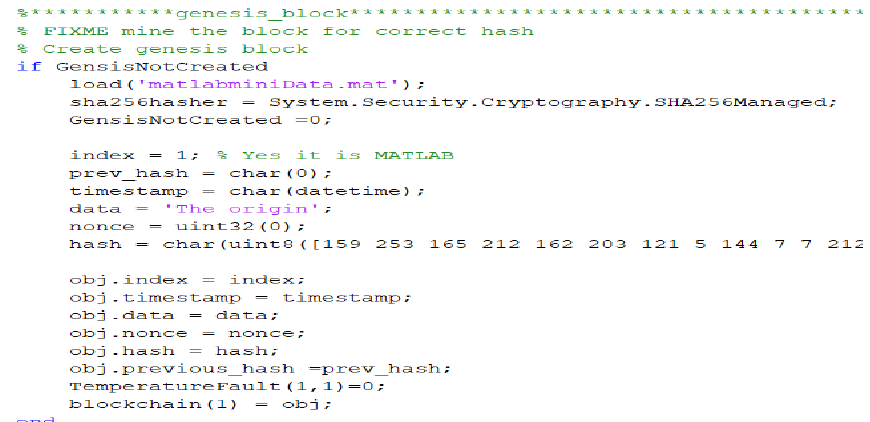
Figure A1. The code checking the creation of the genesis block.